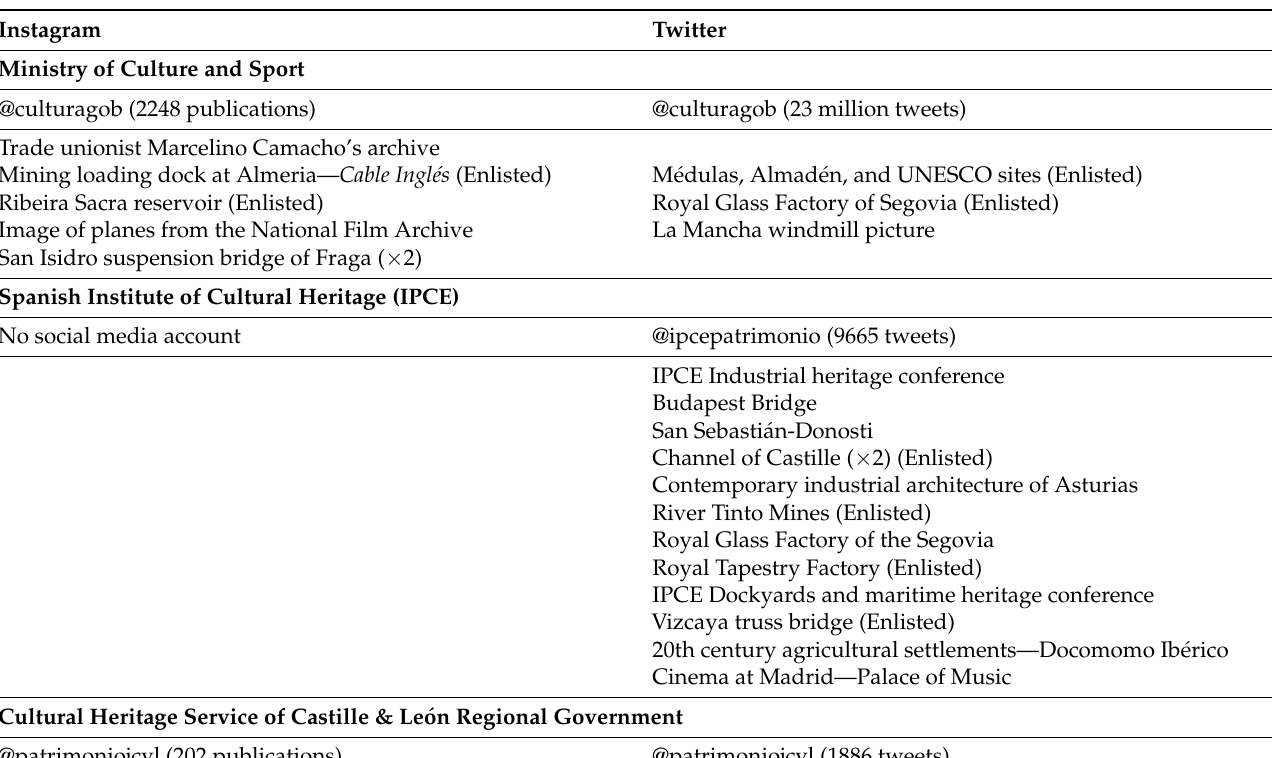
Table 4. Results of sampling #1 for administrative